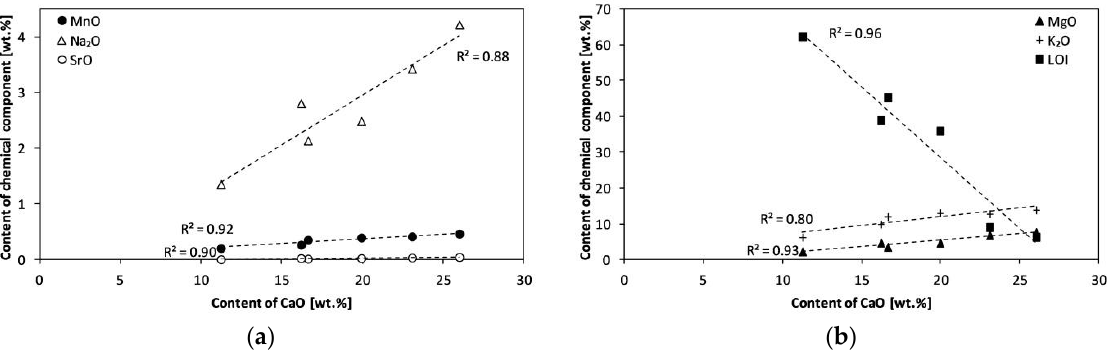
Figure 2. Dependence of the content of selected chemical components on the CaO content in the studied ashes from poultry manure combustion. ( a ) Dependence of the content of MnO, Na 2 O and SrO on the CaO content. ( b ) Dependence of the content of MgO, Ka 2 O and LOI on the CaO content.